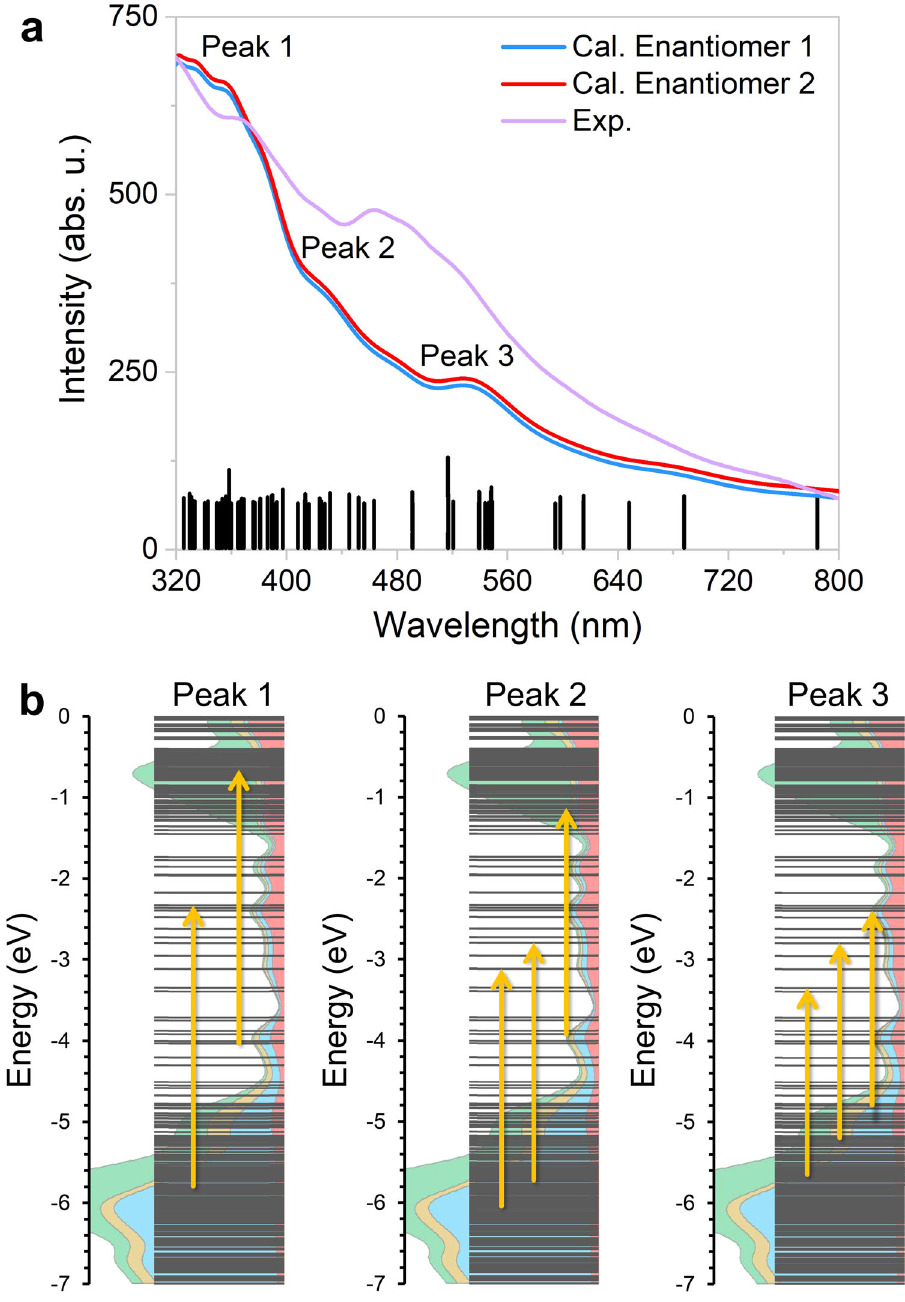
Fig.5|InvestigationofUV-visabsorption.a UV – visabsorptionspectrum(purple line) of Au 138 (SR) 48 in dichloromethane at room temperature 48 and the calculated spectra (red and blue lines) of the two enantiomers with STDDFT formalism and PBE/SVP level of theory. The stick spectra are illustrated for the selected 100 transitions with the highest oscillator strength. b Excited-state analysis for the